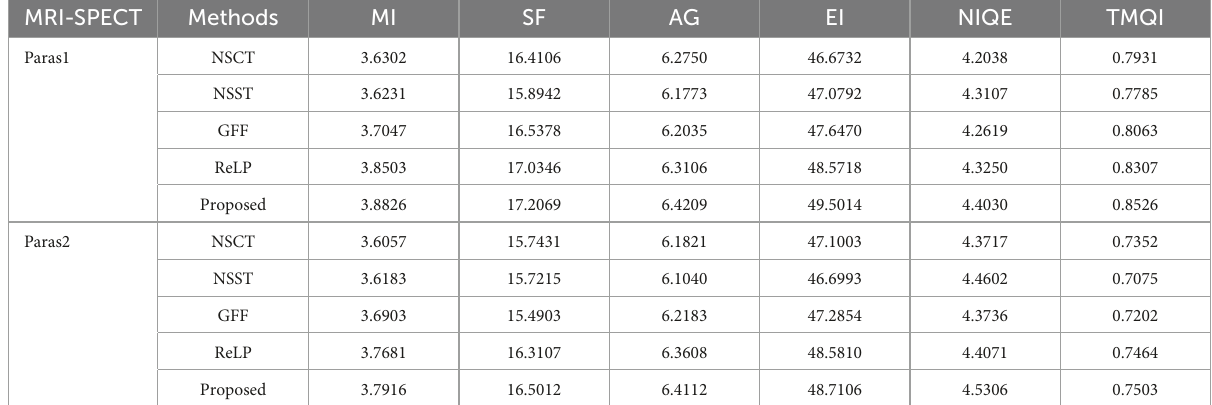
TABLE 3 Average values of index evaluation of different fusion methods for